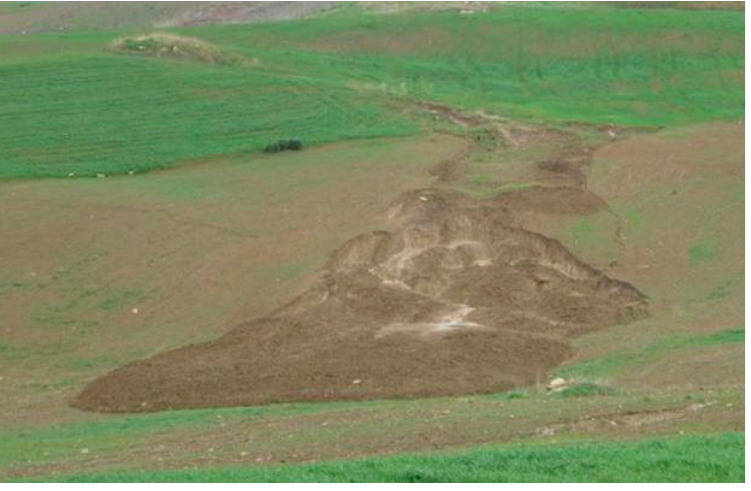
Figure 2. View of the surveyed area.